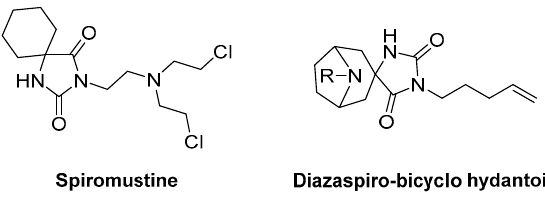
Figure 1. General structures of spiromustine [5] and diazaspiro-bicyclo hydantoin from [8].